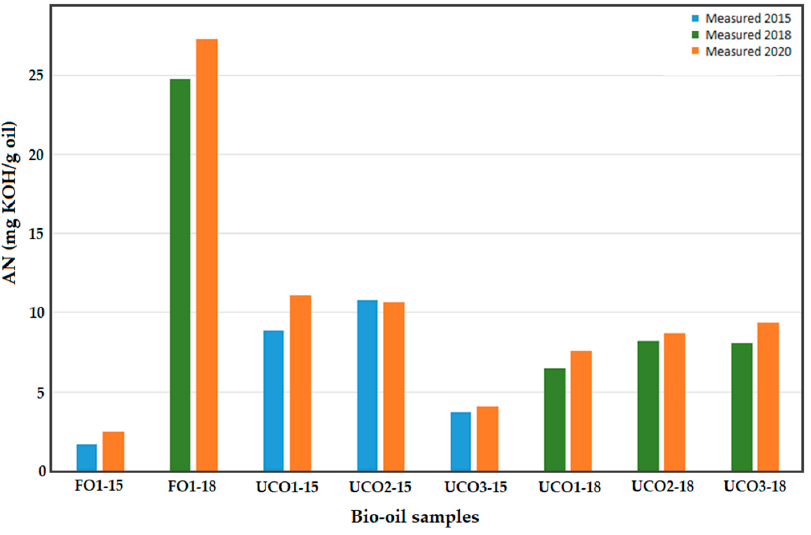
Figure 3. Acid number for bio-oils measured in the years 2015, 2018, and 2020.